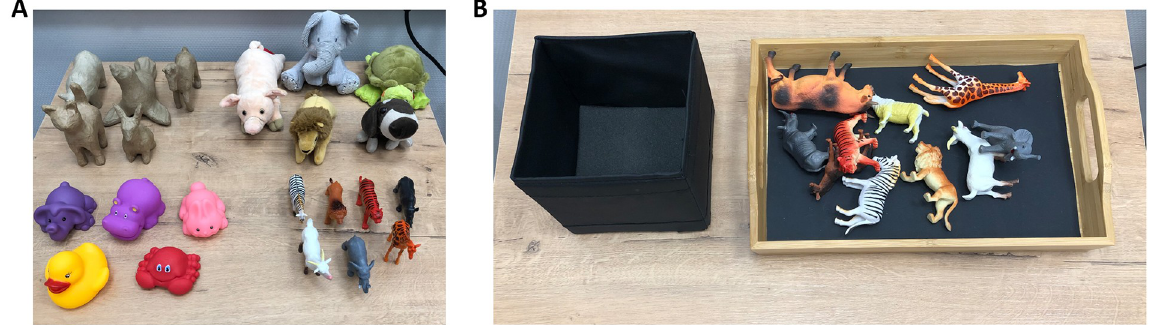
Fig 6. (A) 4 collections of animal toys used in Experiment 2: pulp-paper (left-top), stuffed (right-top), plastic-cartoon-like (left bottom), and plastic-realistic (right-bottom) animals. (B) The collection of toy animals on the tray, and the open box as they were arranged on the desk before each